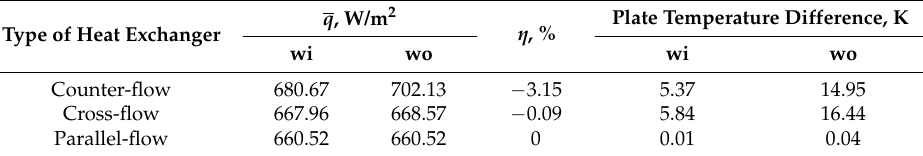
Figure 9. The plate temperature distributions of counter-flow plate heat exchanger ( a ) Heat transfer model with LHC; ( b ) Heat transfer model without LHC. Table 1. Results of calculation for different heat exchangers in balanced flow: average heat flux q ; contribution of longitudinal heat conduction η ; plate temperature difference.